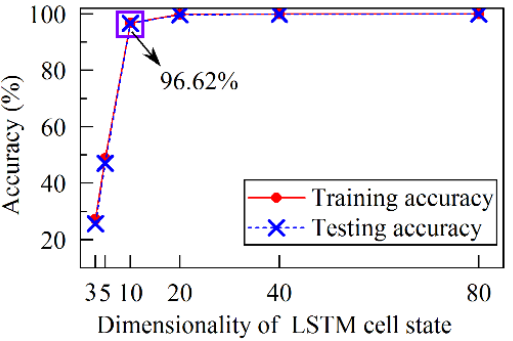
Figure 16. Training and testing accuracies of the fourth network structure and data division mode 1. The purple circle marks the accuracy that is more than 95% with the lowest hidden element number.